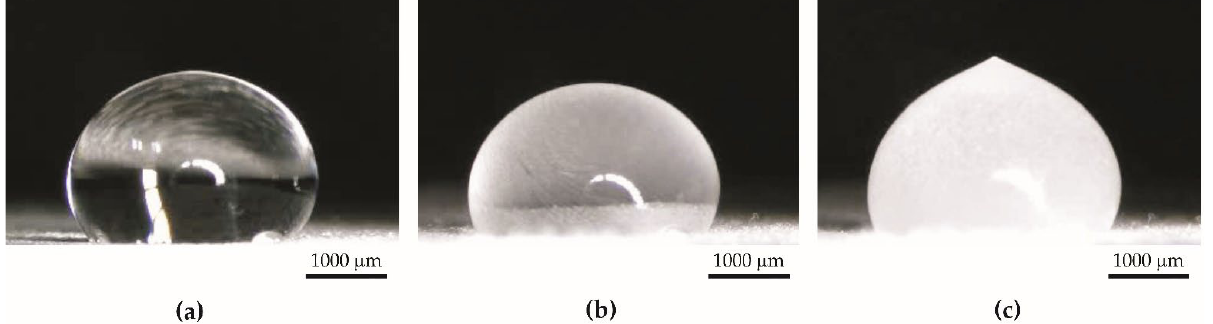
Figure 13. The specimen from Series 2. A drop of water on the specimen surface: ( a ) before icing, ( b ) during icing, ( c ) after complete freezing.